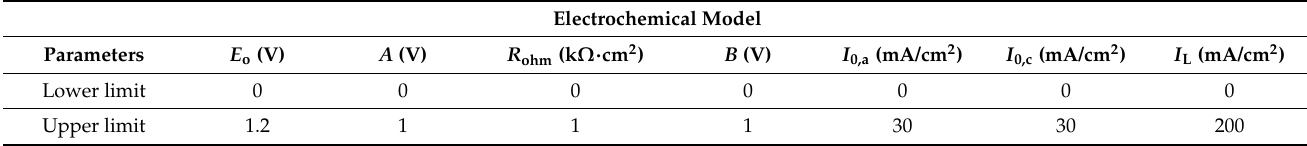
Table 4. The range of unknown